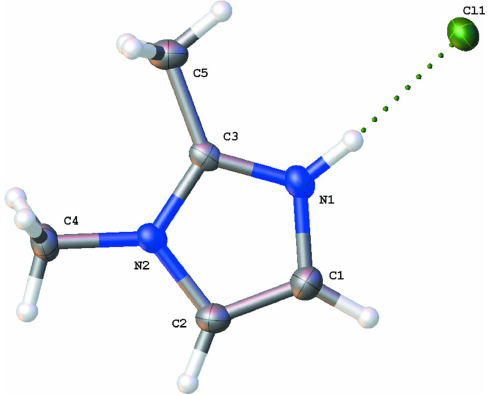
Figure 1 The title compound shown with 50% probability ellipsoids. Carbon (grey), hydrogen (white), nitrogen (blue), chlorine